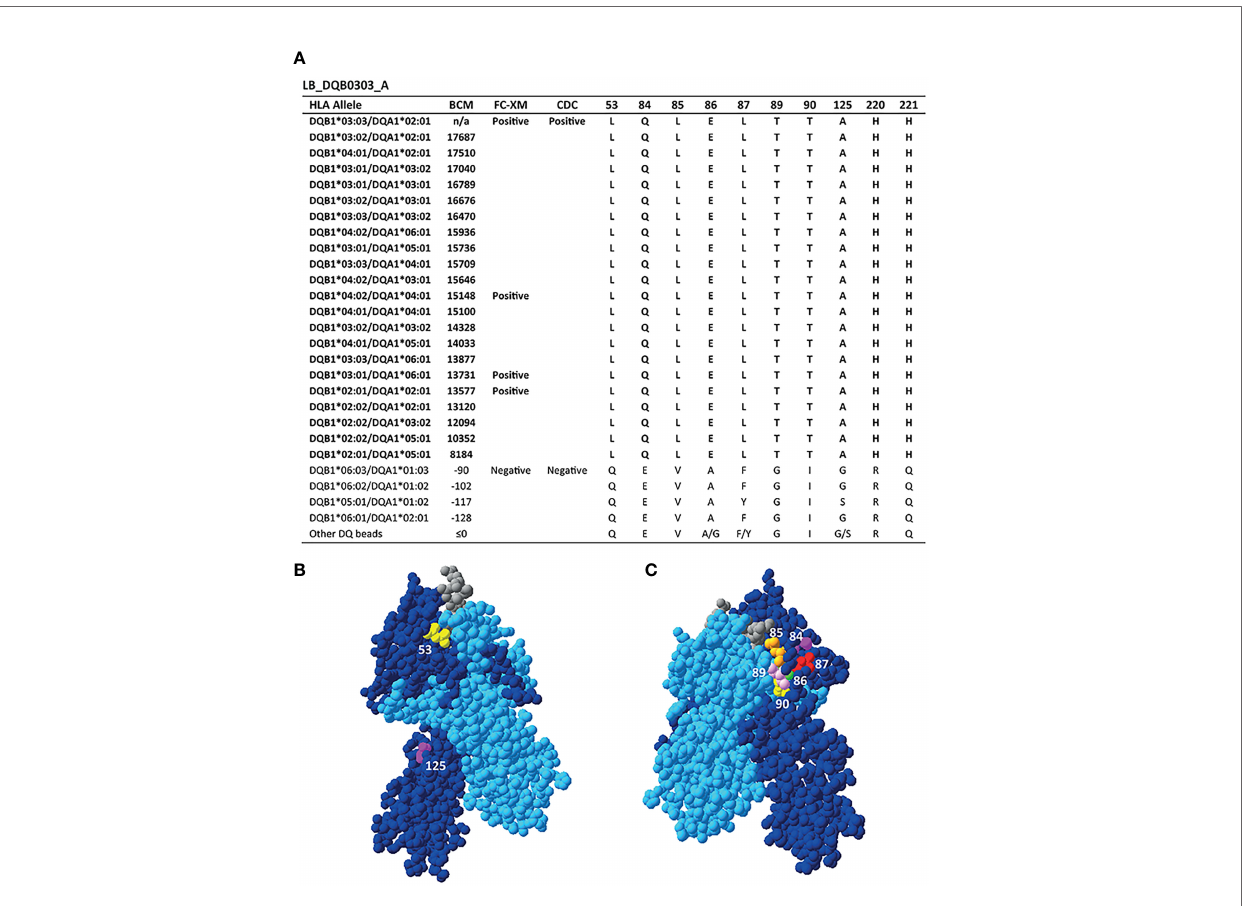
FIGURE 3 | Reactivity analysis of monoclonal antibody LB_DQB0303_A. (A) Comparison of the amino acid positions of interest of the HLA-DQB1 alleles on the reactive beads in the single antigen bead assay and a selection of the non-reactive HLA-DQB1 alleles. HLA-DQB1*03:03/DQA1*02:01 was not present in the single antigen bead panel. Locations of amino acid 53L (yellow), 125A (magenta) (B) and 84Q (magenta), 85L (orange), 86E (green), 87L (red), 89T (pink) and 90T (yellow) (C) are indicated on the crystal structure of DQB1*03:02/DQA1*03:01 (PBD: 4Z7U). The position of residues 220H and 221H could not be determined, as these AAs are not included in the crystal structure. The b chain is depicted in dark blue, the a chain in light blue, and the peptide in grey. BCM, background corrected mean fl uorescence intensity; FC-XM, fl owcytometric crossmatch; CDC, complement dependent cytotoxicity; PBD, Protein Data